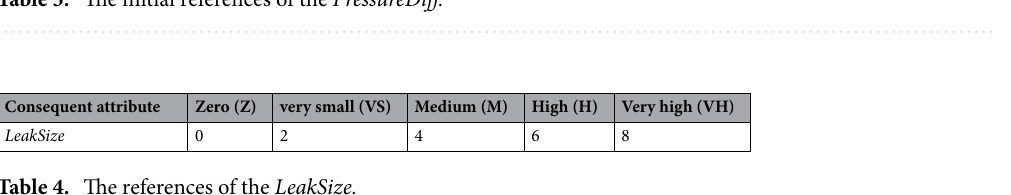
Table 3. The initial references of the PressureDiff.